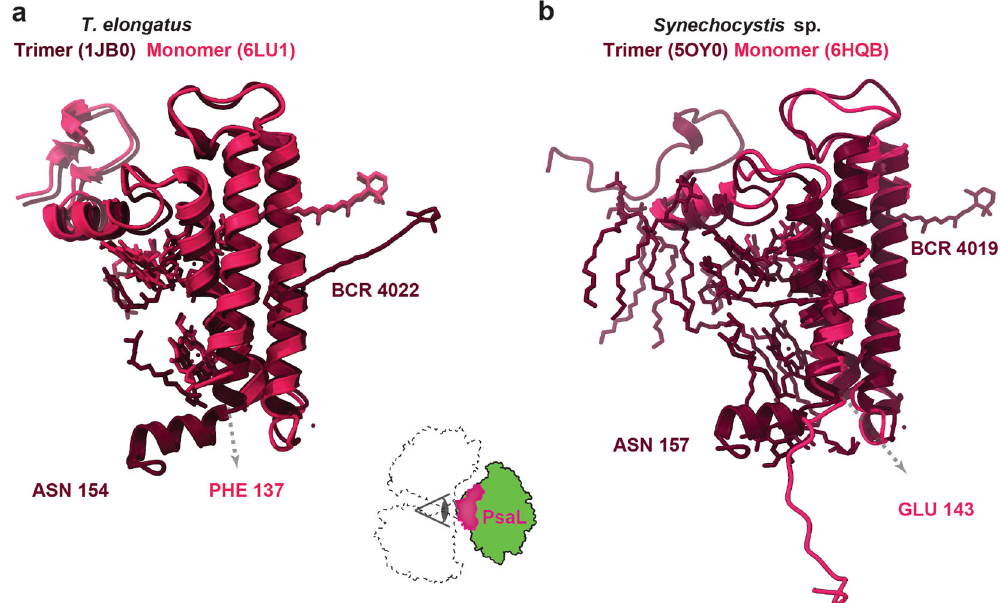
Fig. 5 PsaL subunit as viewed from the center of the PSI trimer. a T. elongatus trimer and monomer superposed for illustration of the absence of the C- terminal α -helix and the PsaL-bound carotenoid BCR4022. The C-terminal phenylalanine in our monomer model of PsaL is indicated by a dashed arrow. b Synechocystis sp. trimer and monomer superposed with the C-terminal glutamate of the monomer model of PsaL indicated by a dashed arrow.